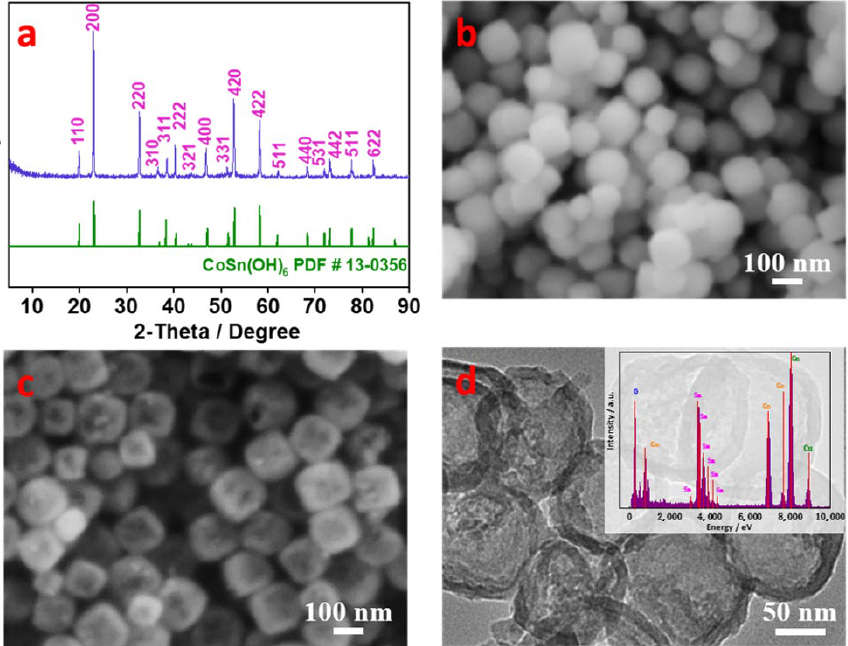
Figure 1. ( a ) XRD pattern of CoSn(OH) 6 nanocubes; SEM images of ( b ) dense and ( c ) hollow CoSn(OH) 6 nanocubes; ( d ) TEM image of hollow CoSn(OH) 6 nanocubes (Inset: EDS analysis).